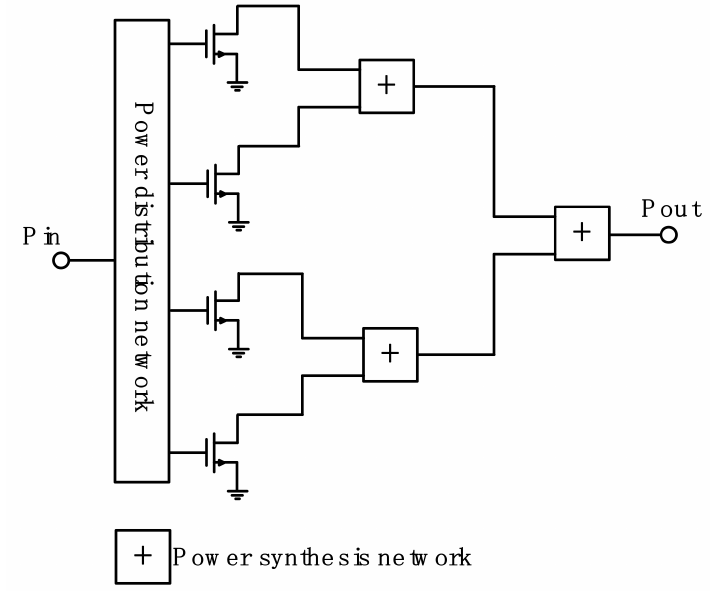
Figure 14. Corporate combiner power amplifier circuit schematic diagram.